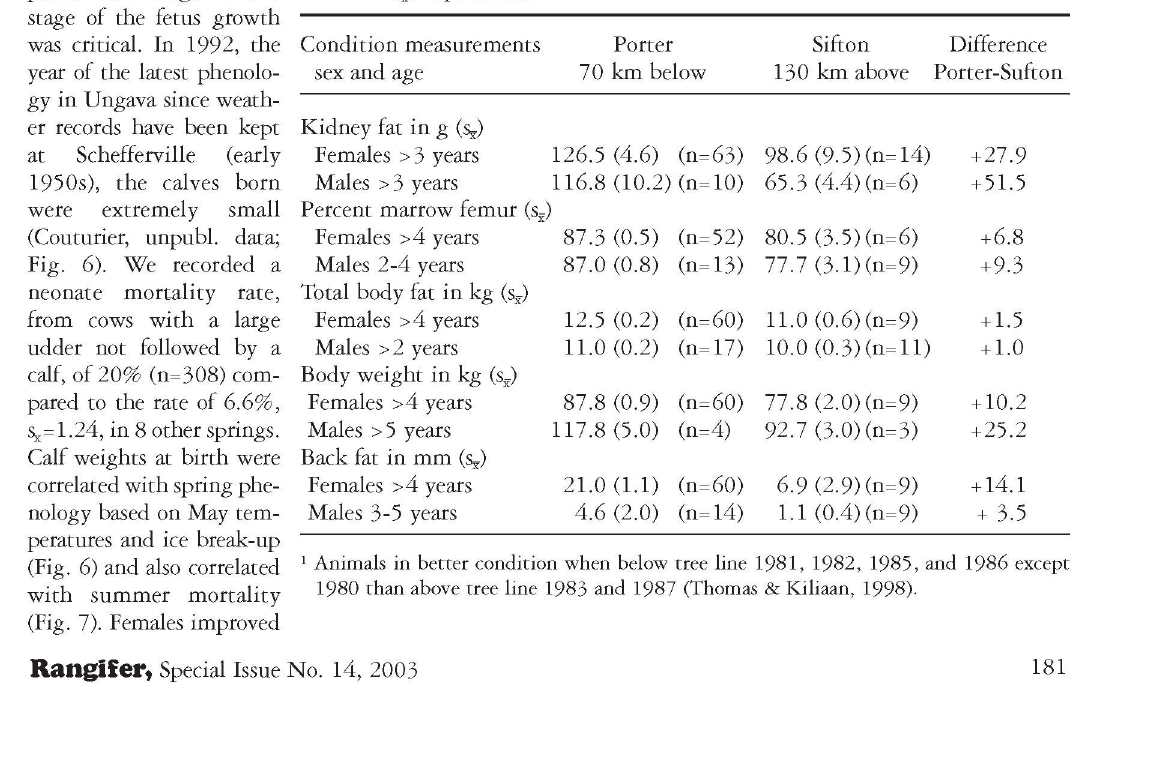
Table 9. Comparison of the body condition of caribou in the Beverly Herd, Northwest Territories in March 1984, above treeline (Sifton) and below treeline (Porter) taken from Thomas & Kiliaan (1998). Mean value, standard error of the mean (%) in